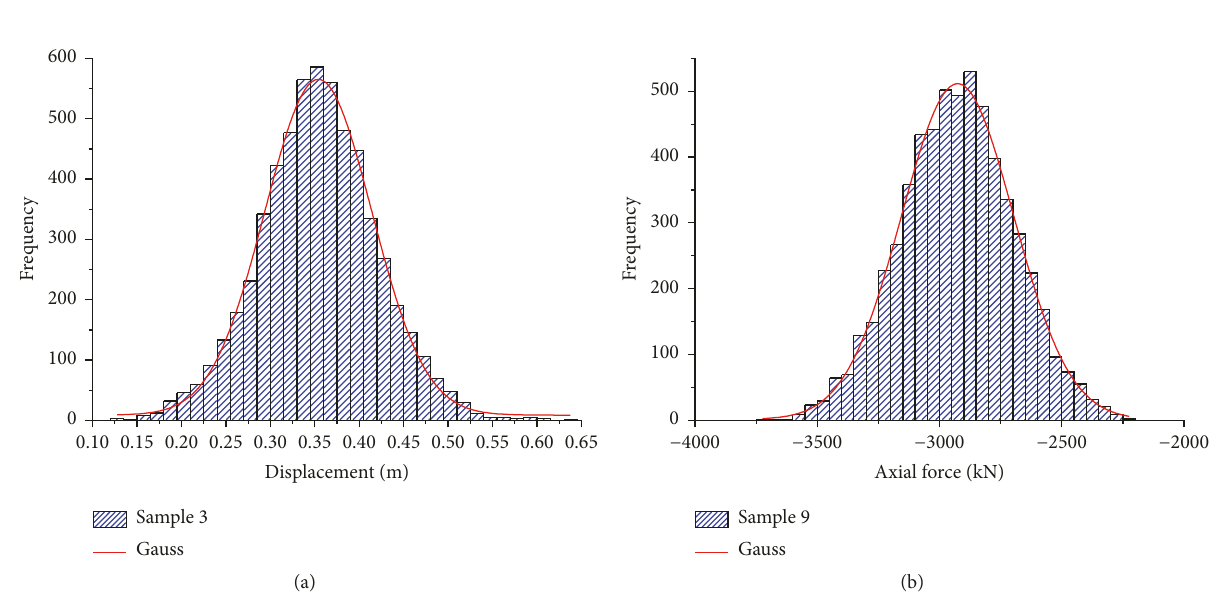
Figure 8: Frequency histogram of single high tower under wind field